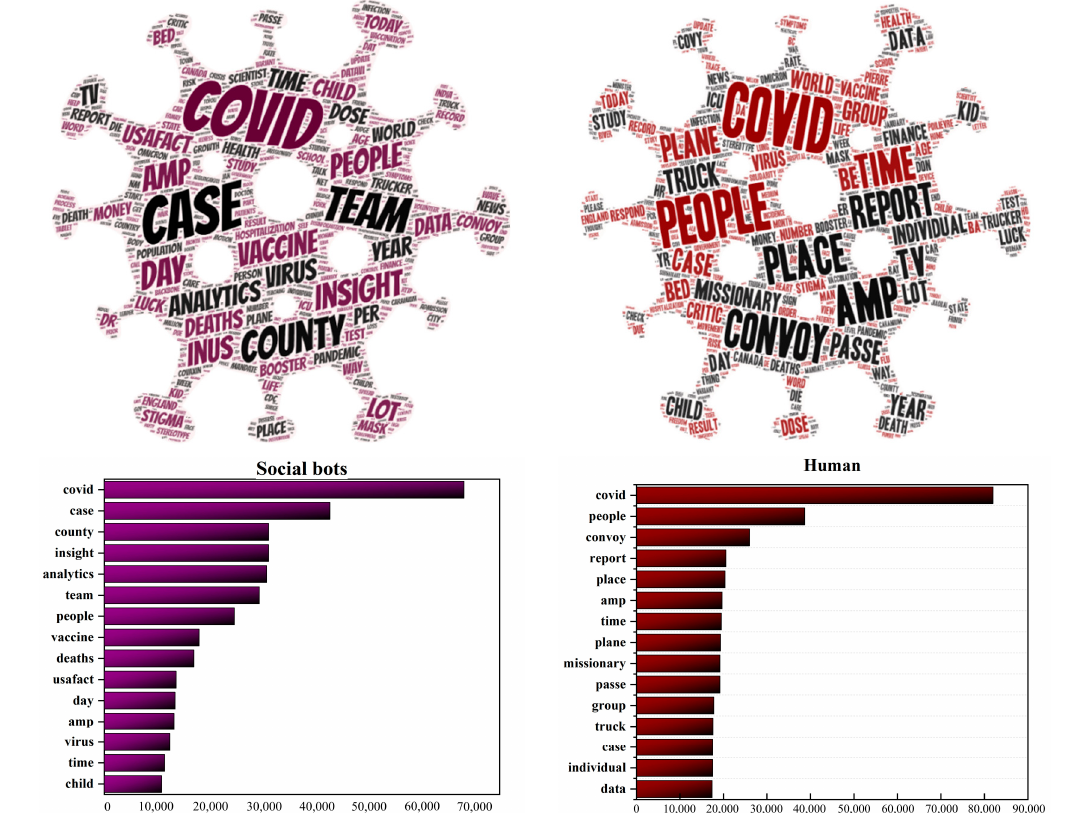
Figure 5. Word cloud and word frequency distribution of tweets posted by social bots and humans.